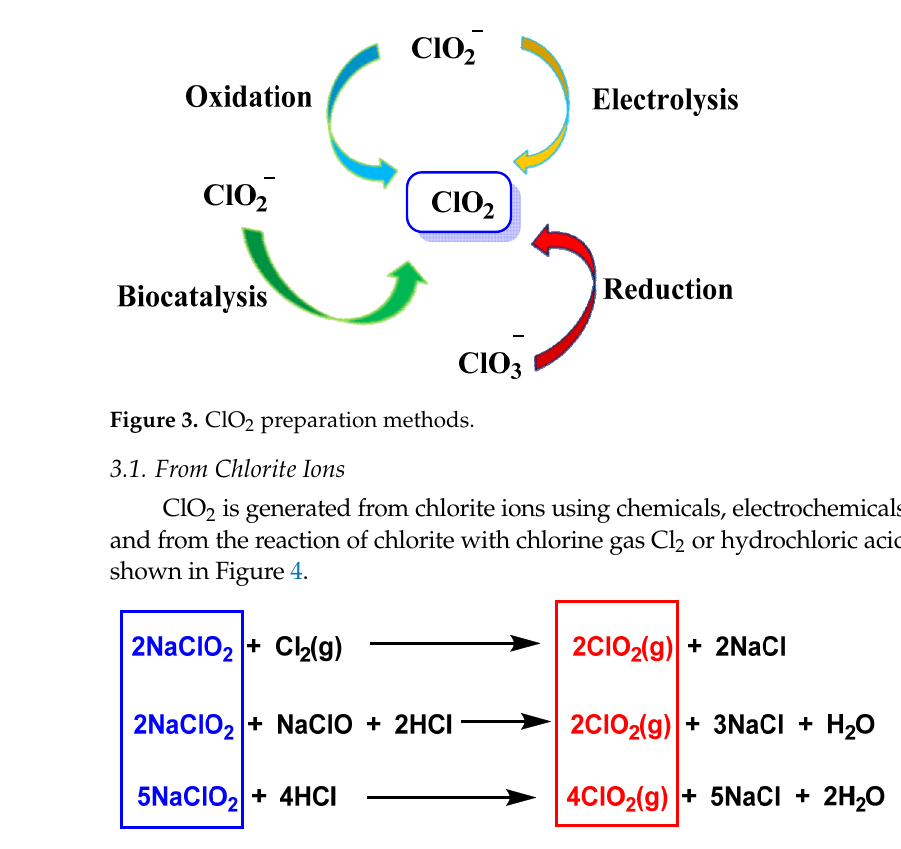
Figure 4. Preparation of chlorine dioxide from sodium chlorite.